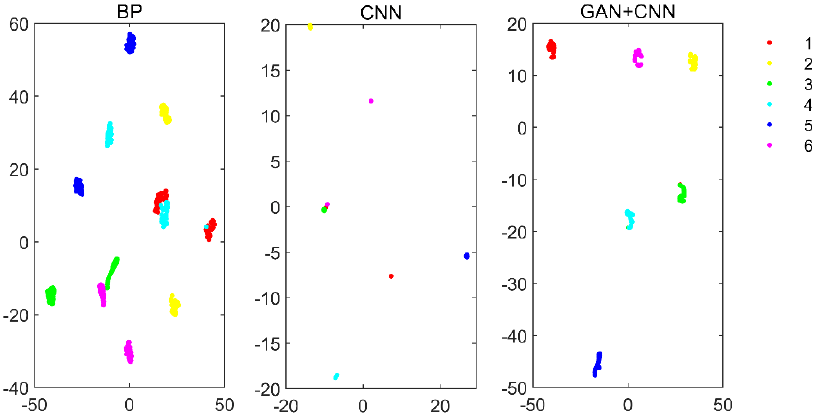
Figure 14. Feature visualization for BP, CNN and GAN by using t-SNE.